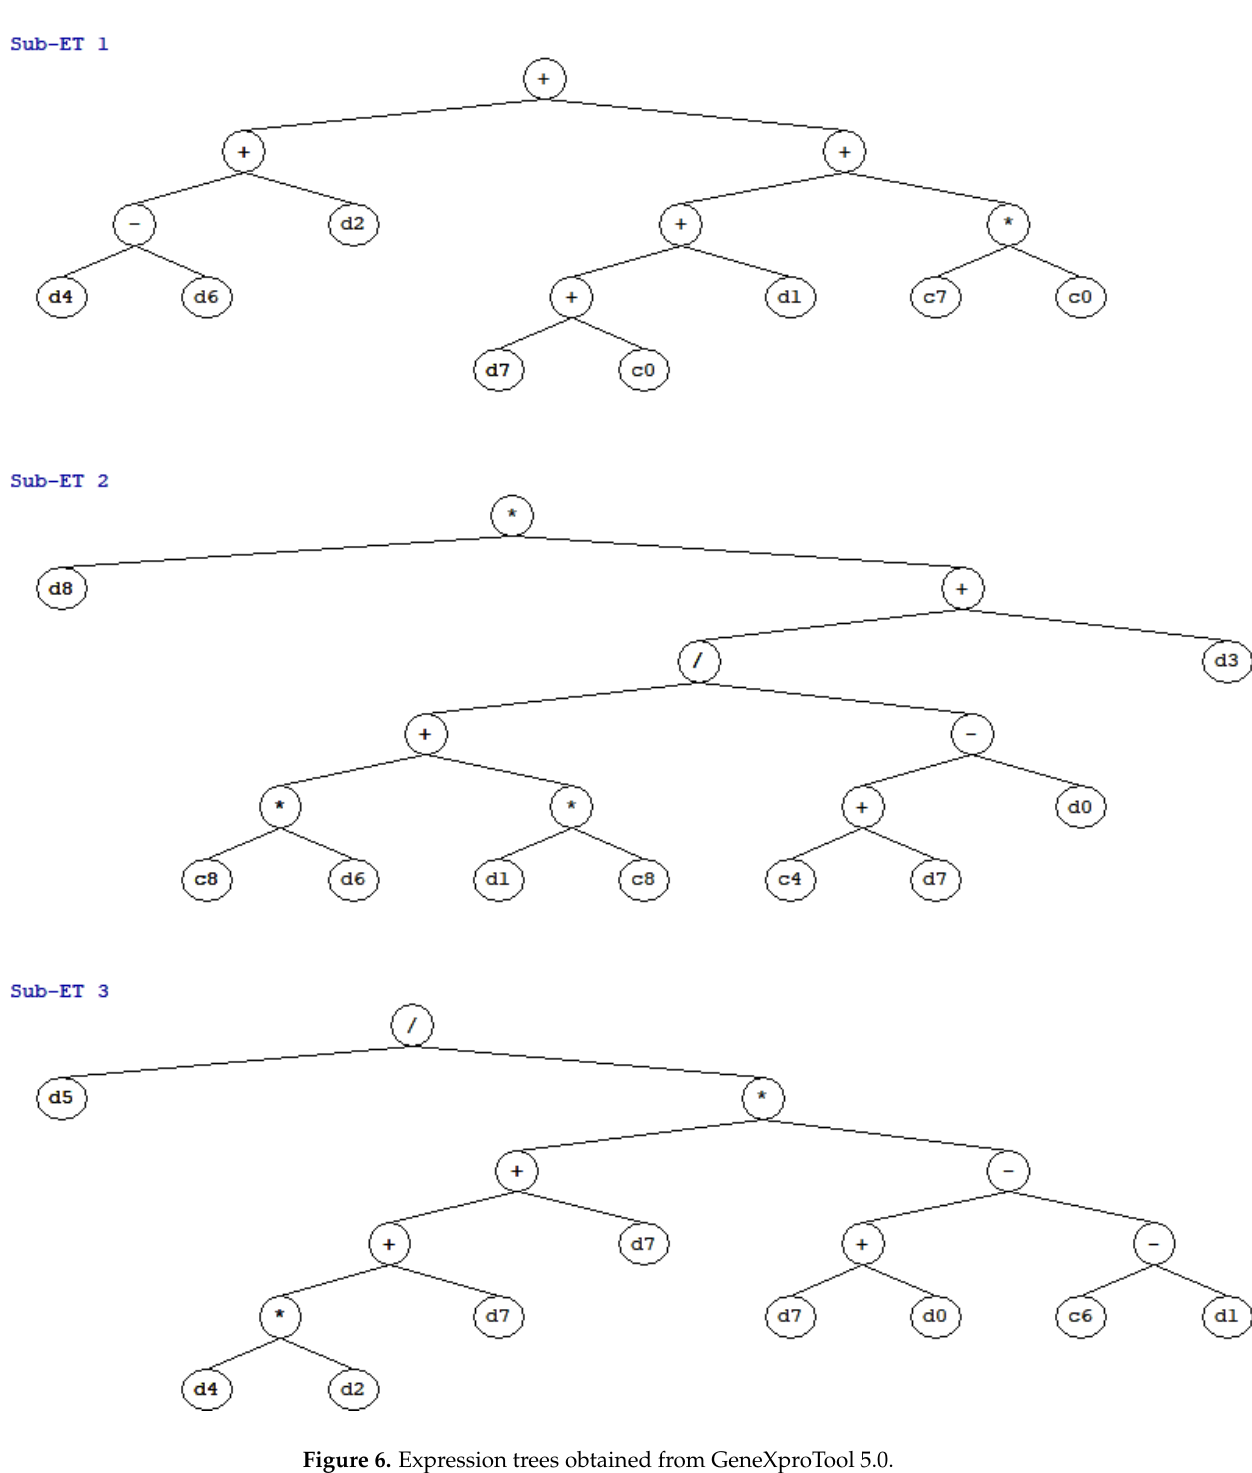
Figure 6. Expression trees obtained from GeneXproTool 5.0.